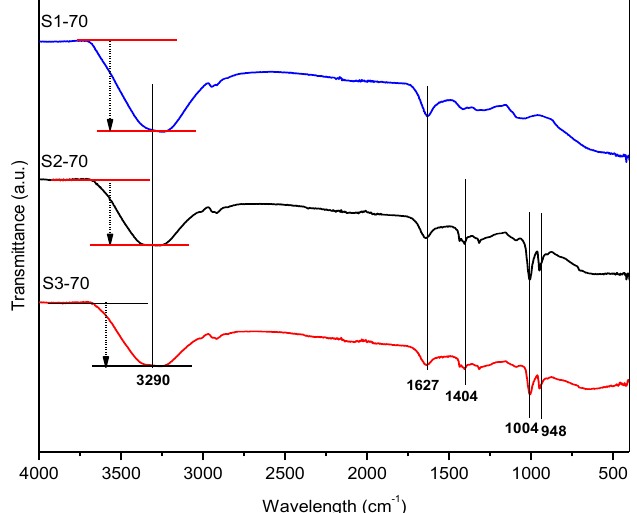
Figure 1. FTIR spectra of hydrogel magnetorheological plastomer (MRP) samples prepared with di ff erent types of solvents.